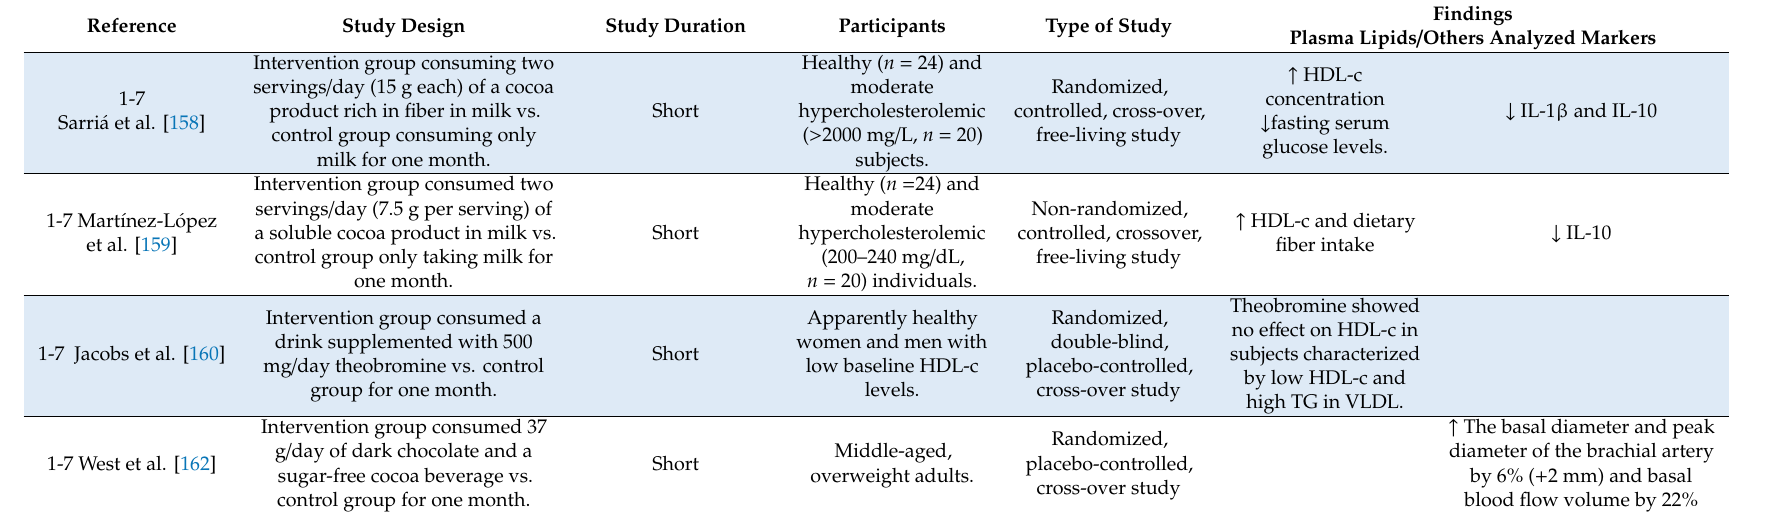
Table 6. Potential protective e ff ect of cocoa or its bioactive compounds on proinflammatory and oxidative stress markers during the progression of